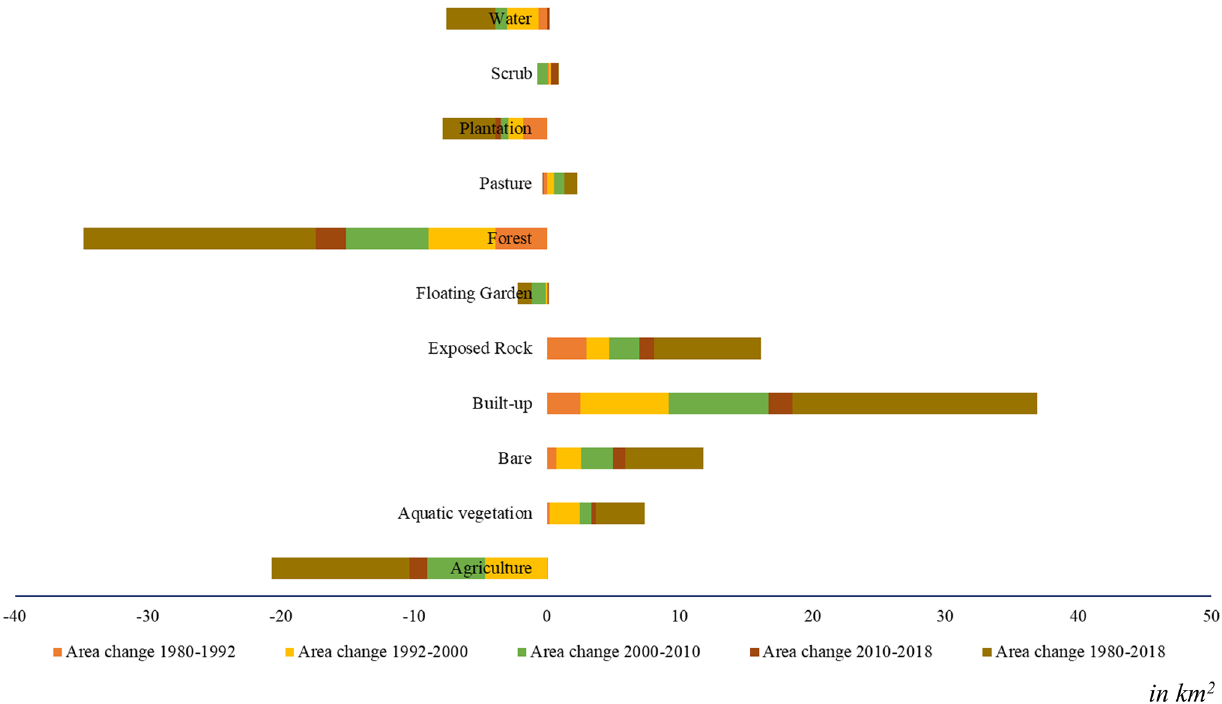
Fig. 9 Stacked bar chart showing area changes (in km 2 ) in LULC categories over last 04 decades in the Dal Lake watershed